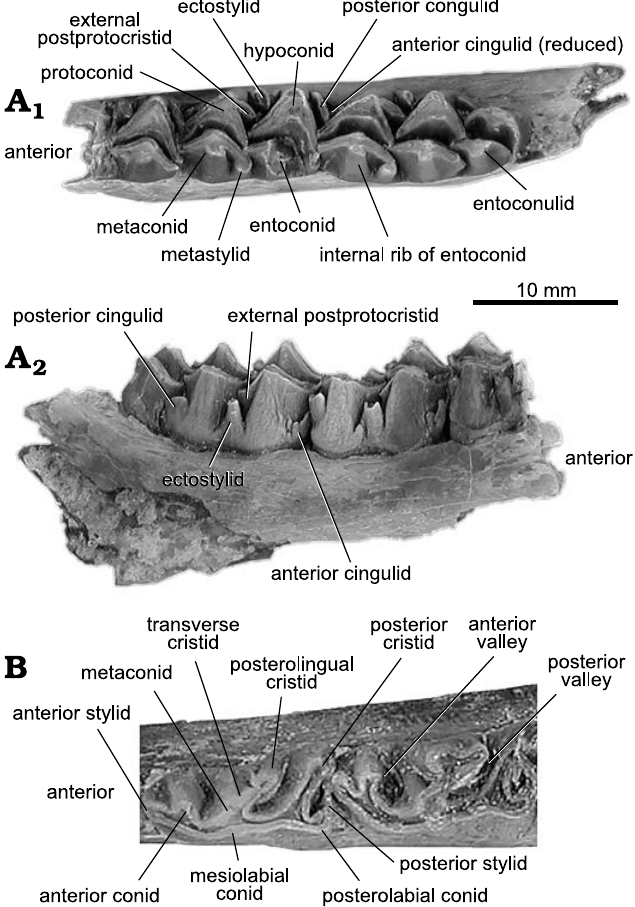
Fig. 6. Dental terminology for palaeomerycid artiodactyl Barbouromeryx trigonocorneus (Barbour and Schultz, 1934), from Eastgate, Churchill County, Nevada, USA; early Barstovian, middle Miocene. A . UCMP 141518 from UCMP V70138; right dentary fragment with m1 fragment and m2–m3 in occlusal (A 1 ) and labial (A 2 ) views. B . UCMP 141669 from UCMP V70140; left dentary fragment with p3–m3 in occlusal view